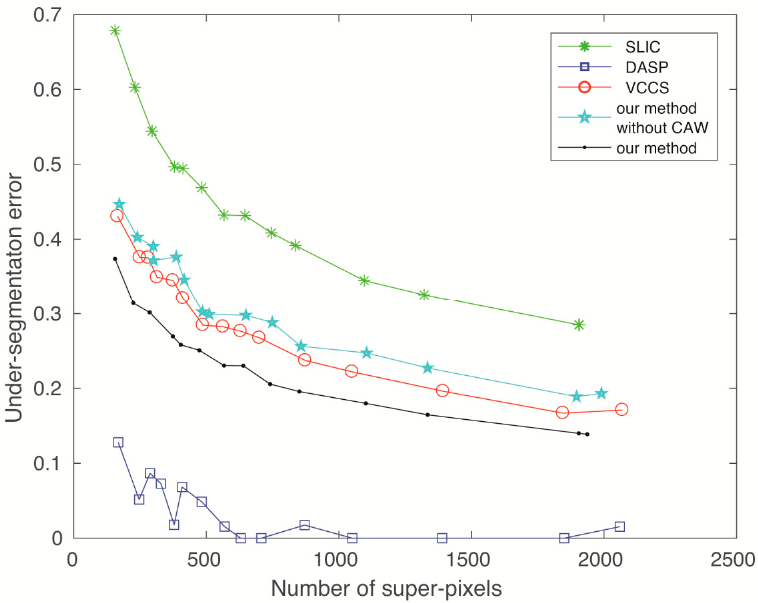
Figure 6. The undersegmentation errors of the four superpixel methods.